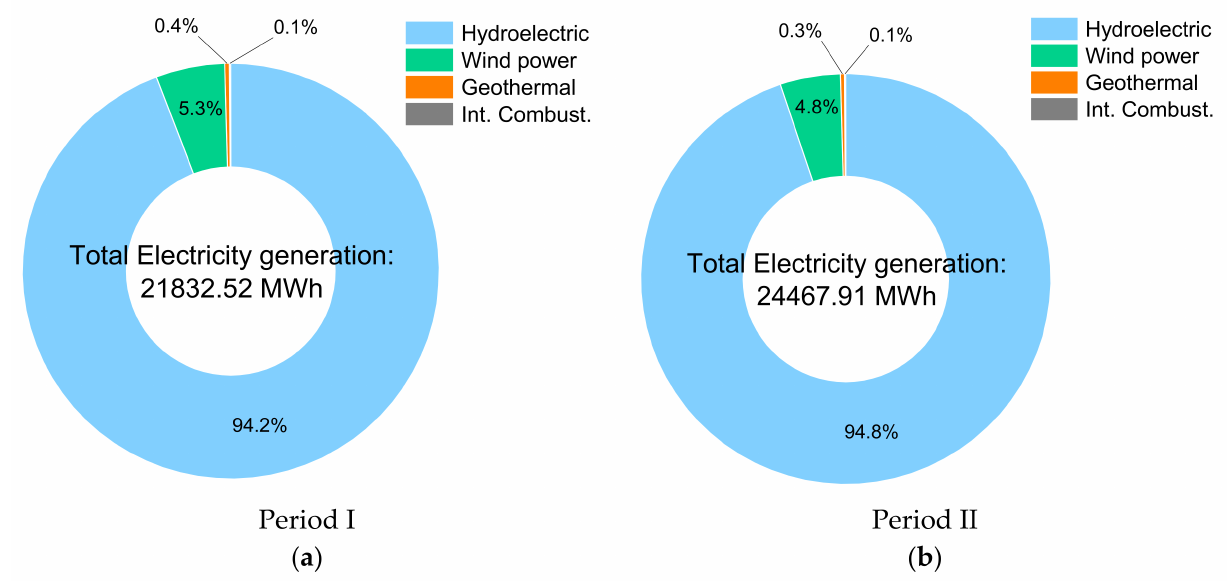
Figure 5. Generation and Energy in periods 1 and 2. ( a ) Period 1. ( b ) Period 2.